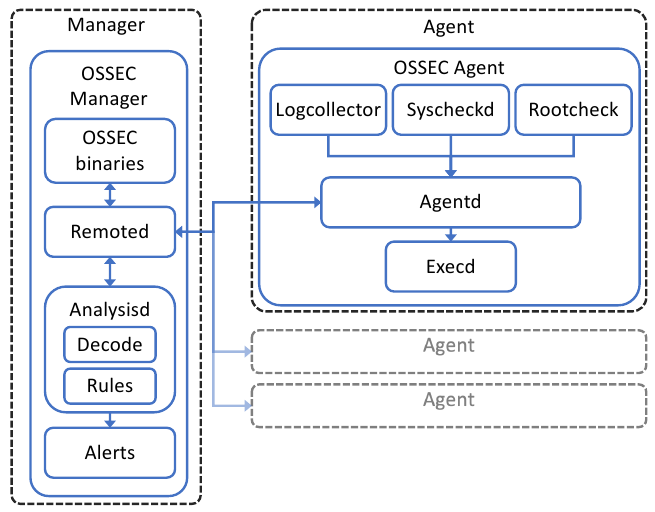
Figure 1. Open Source Host-based Intrusion Detection System (OSSEC)